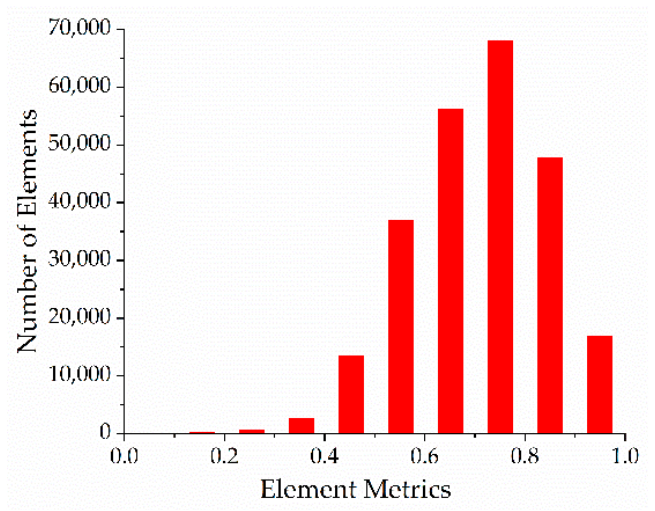
Figure 2. Grid division results.